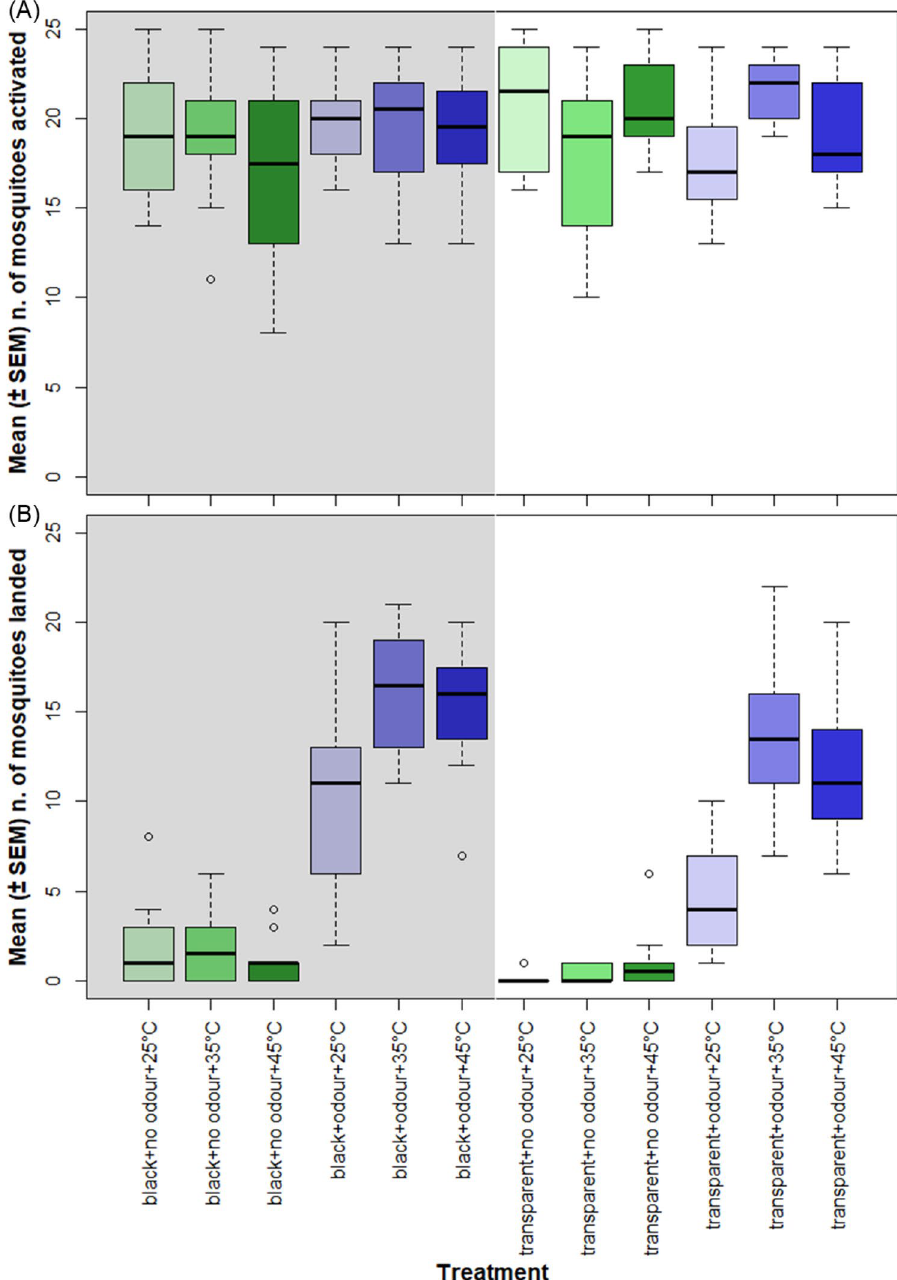
Figure 2. Mean number (± SEM) of mosquitoes activated ( A ) and mean number (± SEM) of mosquitoes found on the landing surface ( B ) for each treatment. Bold black bars indicate the median; upper and lower limits of a box indicate the interquartile range; whiskers indicate the maximum and minimum data points, excluding outliers, which are indicated by the circles. The y-axis shows the twelve different treatments, where “black” and “transparent” indicate the different visual cues offered, “no odour” and “odour” indicate the absence or presence of host odour, and the temperature indicates the thermal cue used. Blue bars indicate host odour was present during assays, green bars indicate it was absent. Paler colours denote lower temperatures and darker colours indicate higher temperatures. Background colour indicates the presence (grey) or absence (white) of the visual